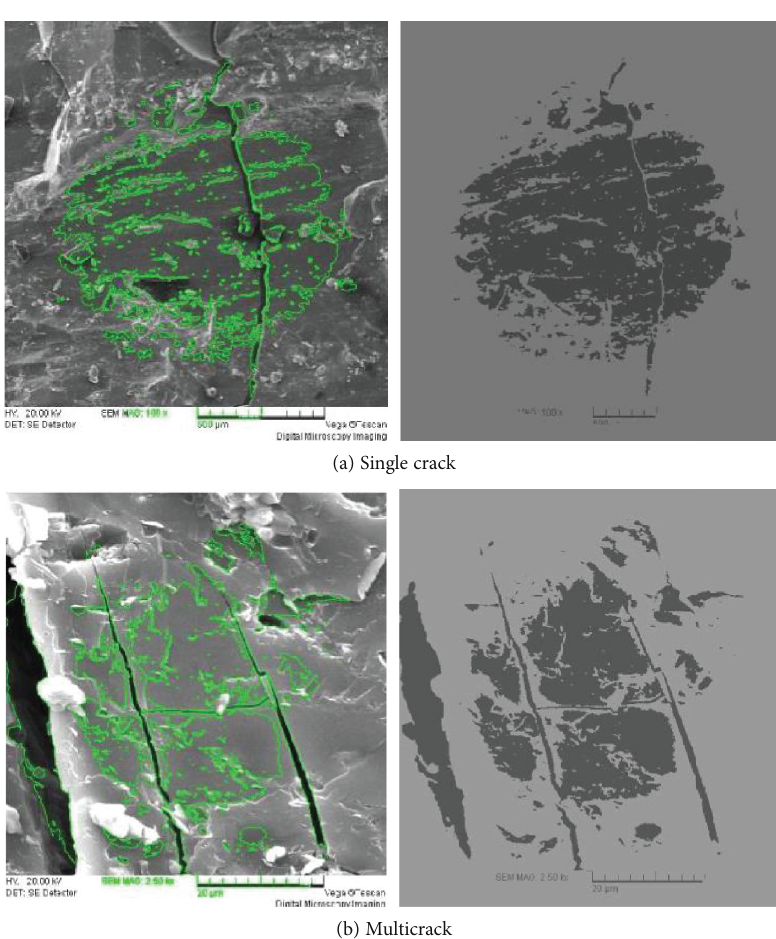
Figure 2: Segmentation of the image by the C-V model (10000 times